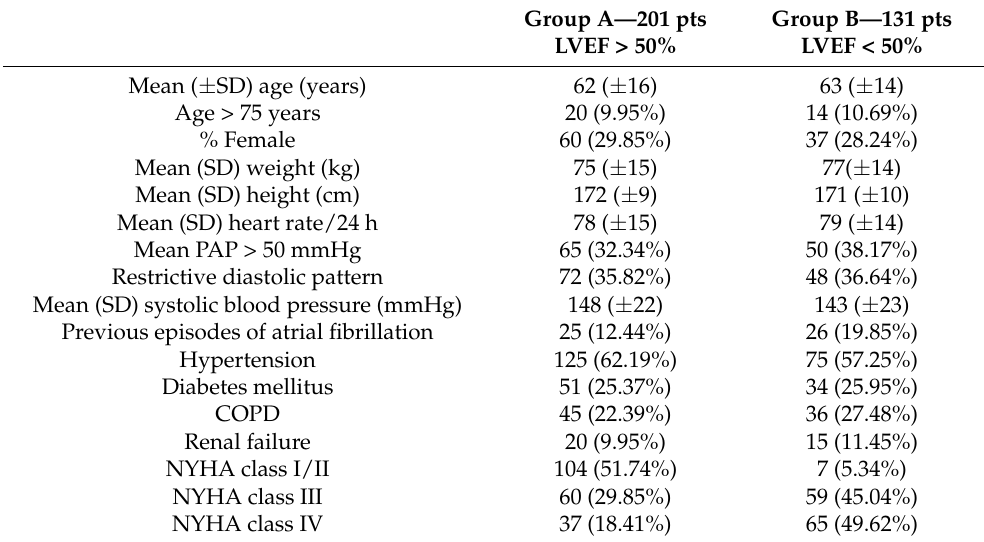
Table 1. Baseline characteristics of study patients (n =